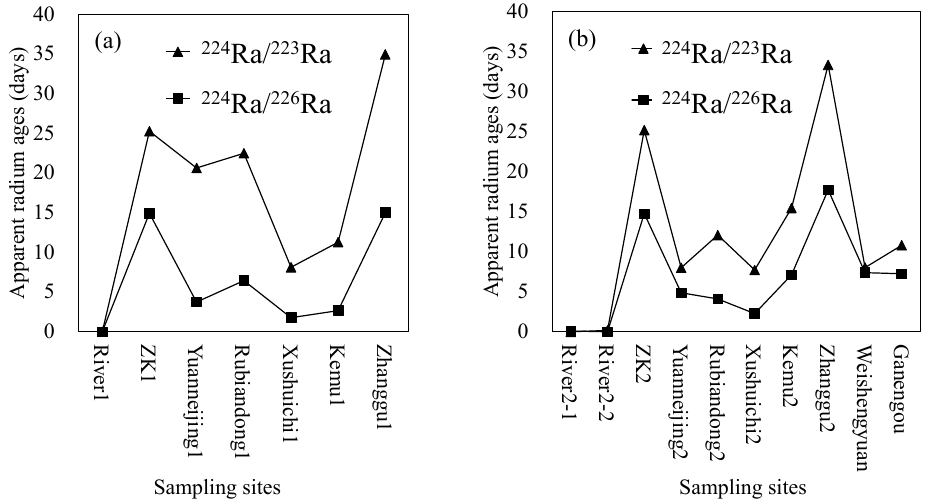
Figure 10. Apparent radium ages of the water samples based on the 224 Ra / 223 Ra radium